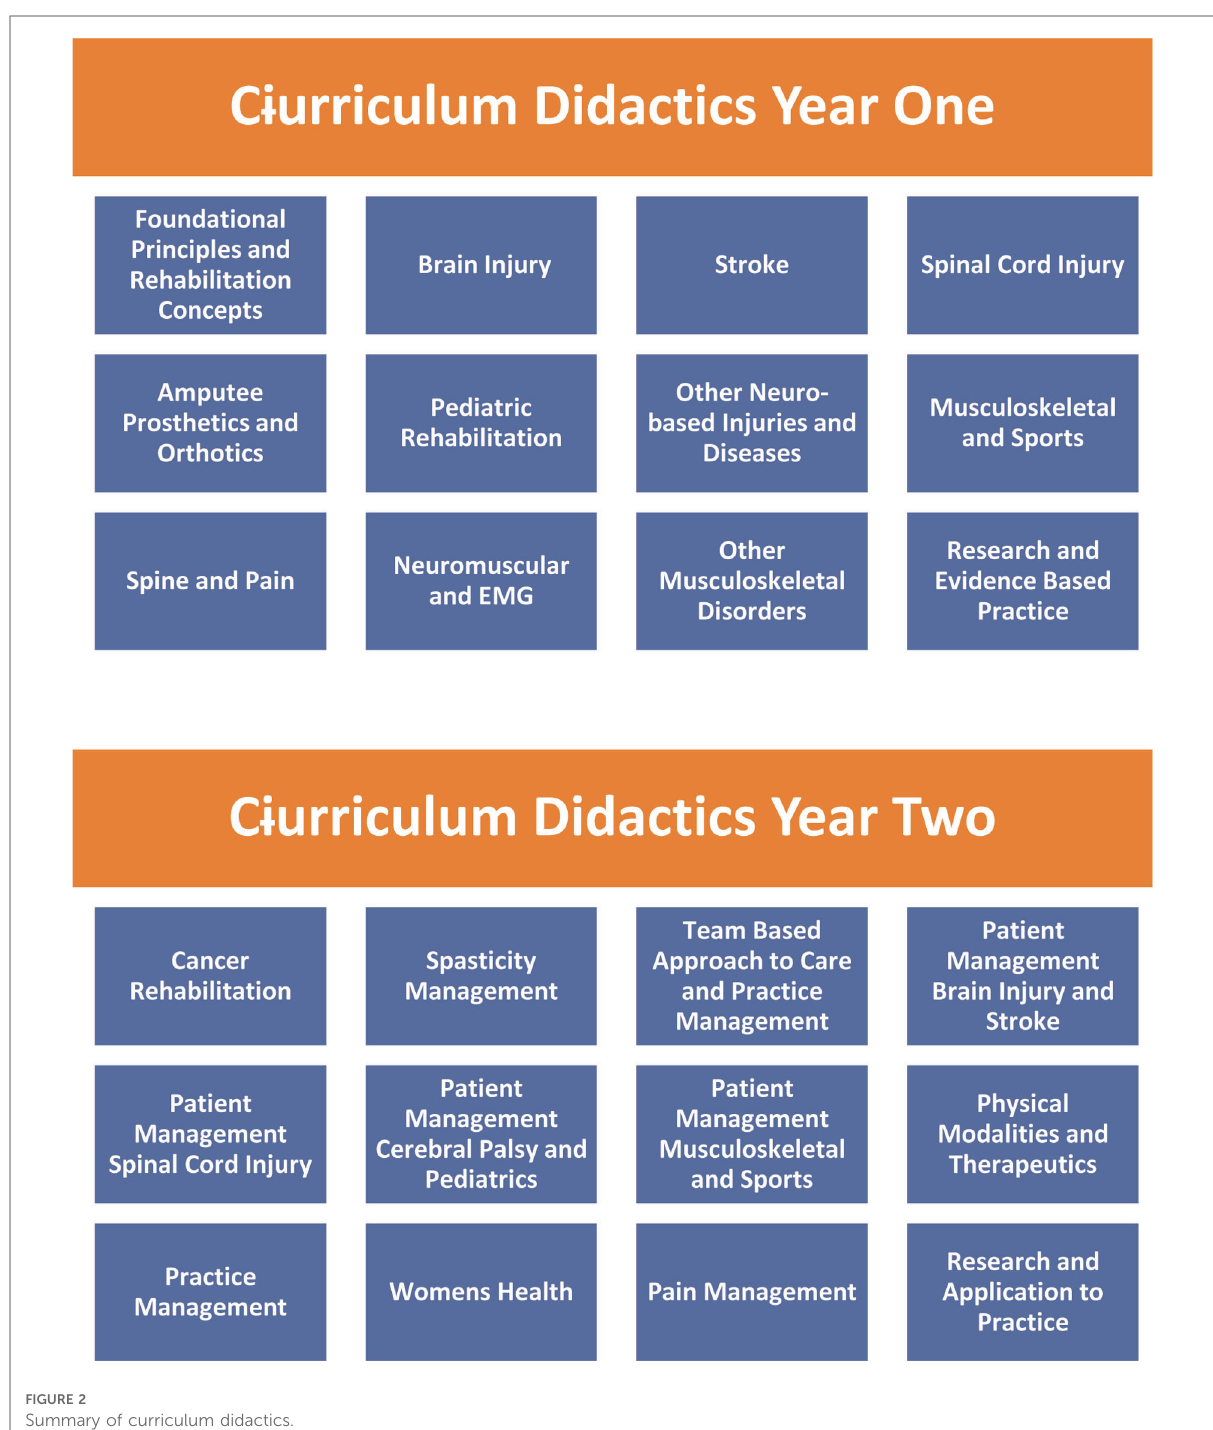
FIGURE 2 Summary of curriculum